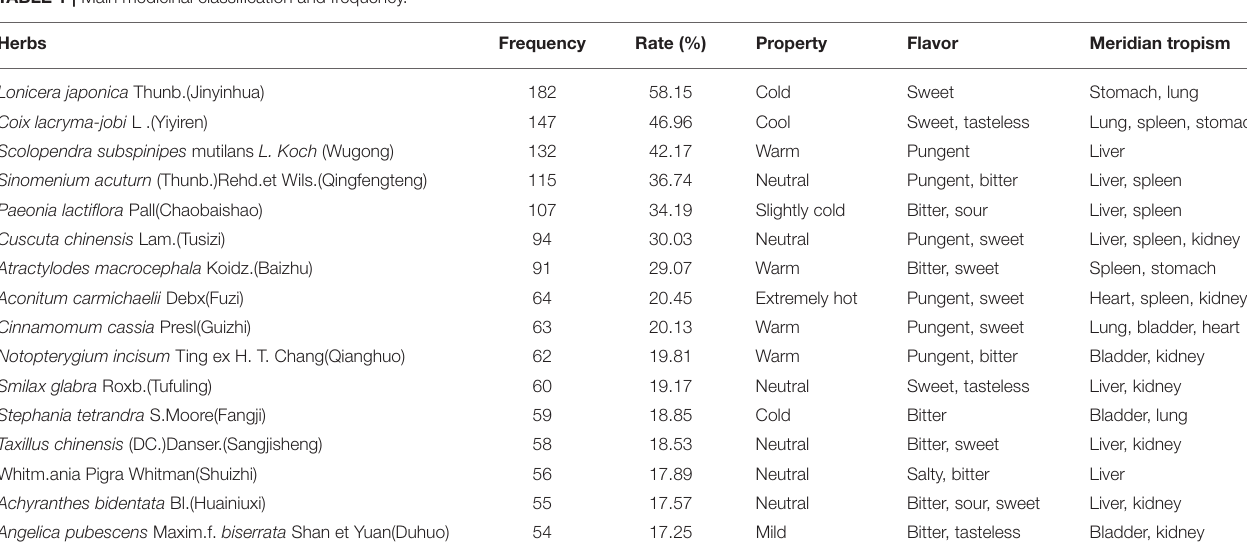
TABLE 1 | Main medicinal classification and